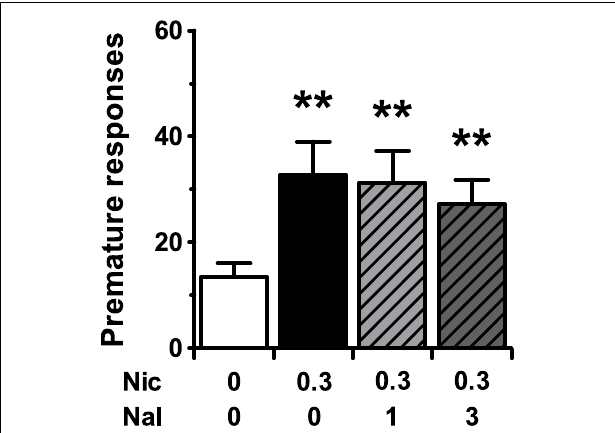
FIGURE 2 | Pretreatment with the opioid receptor antagonist naloxone does not affect motor impulsivity induced by the psychostimulant nicotine. Effects of naloxone (NAL) on the mean ( ± SEM) number of premature responses made in the 5-CSRTT following a challenge injection with 0.3mg/kg nicotine (NIC). In total n = 16 rats were included in the analyses. Drug doses are expressed as mg/kg. ** p < 0.005 versus Vehicle–Vehicle control.